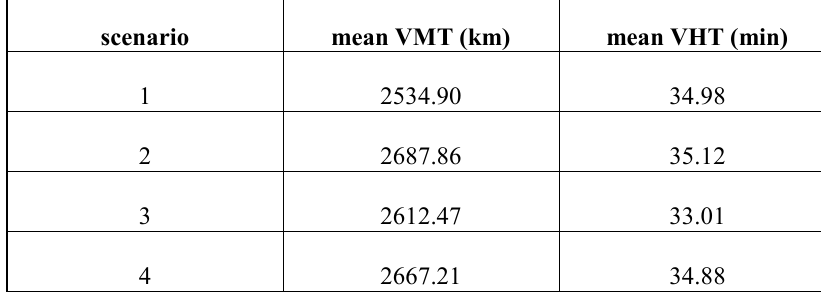
The results of the mean VMT and VHT in each of the four